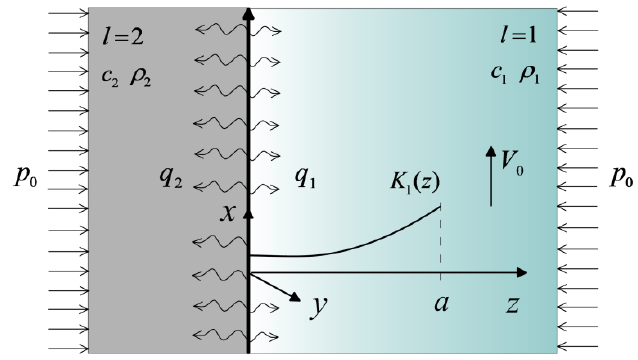
Figure 1. Scheme of the system.